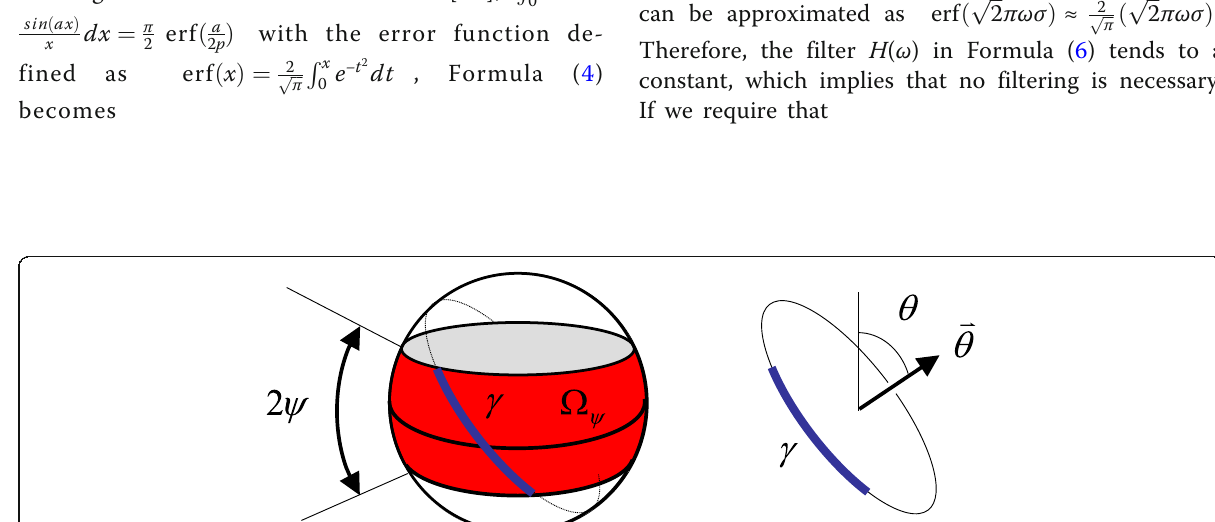
Using the formula 3.952.6 in ref. [17], dx ¼ π erf ð a Þ with the error function de- 2 2 p